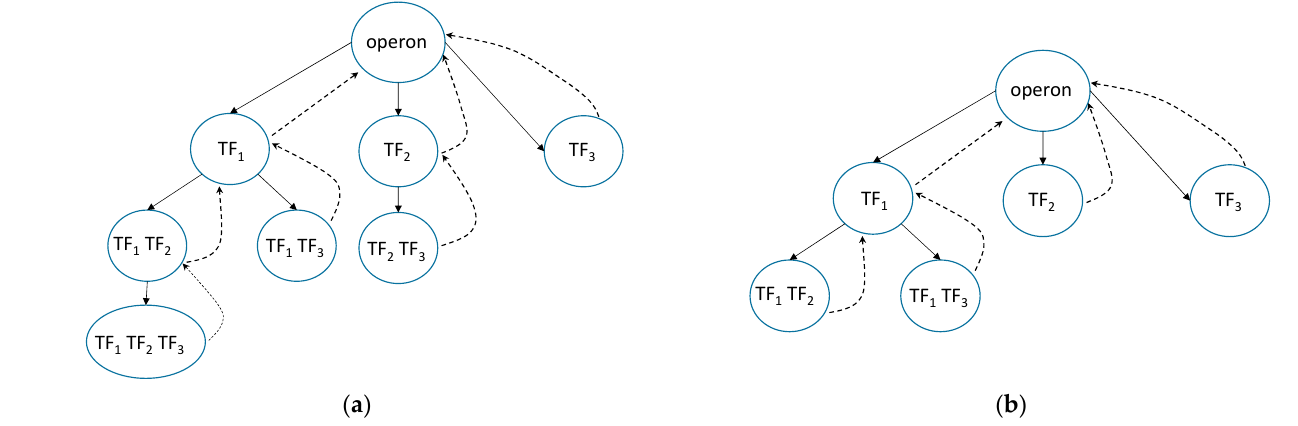
Figure 3. DFS schemes where the solid arrows mark a direct traversal, and the dotted arrows mark a reverse traversal: ( a ) all kinds of bindings for 3 TFs, whose TBFSs do not overlap; ( b ) all kinds of bindings for 3 TFs with overlapping TF2 and TF3 binding sites.